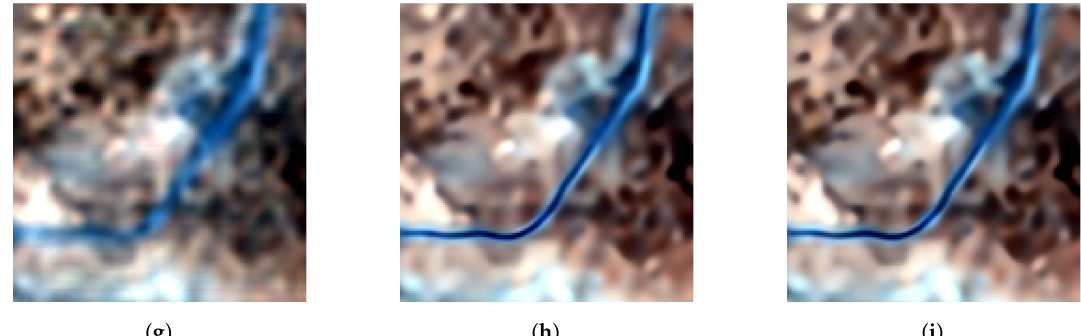
Figure 14. Results of a region of Teide 2017 from the W-S Set1. ( a ) HR, ( b ) LR with NN interpolation, ( c ) LR with bicubic interpolation, ( d ) SRCNN, ( e ) EDSR, ( f ) RCAN, ( g ) SRGAN with α = 0, ( h ) RS-ESRGAN ( α = 0), ( i ) RS-ESRGAN ( α = 0.1). Image size: 140 × 140